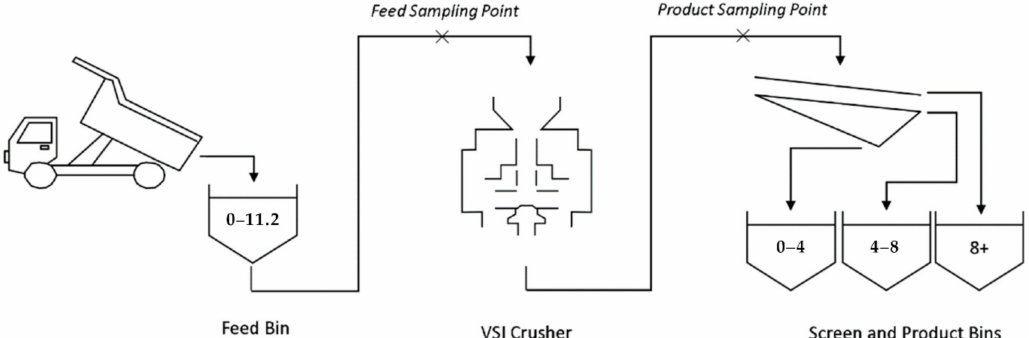
Figure 6. The mobile VSI crusher plant layout used at the different quarries